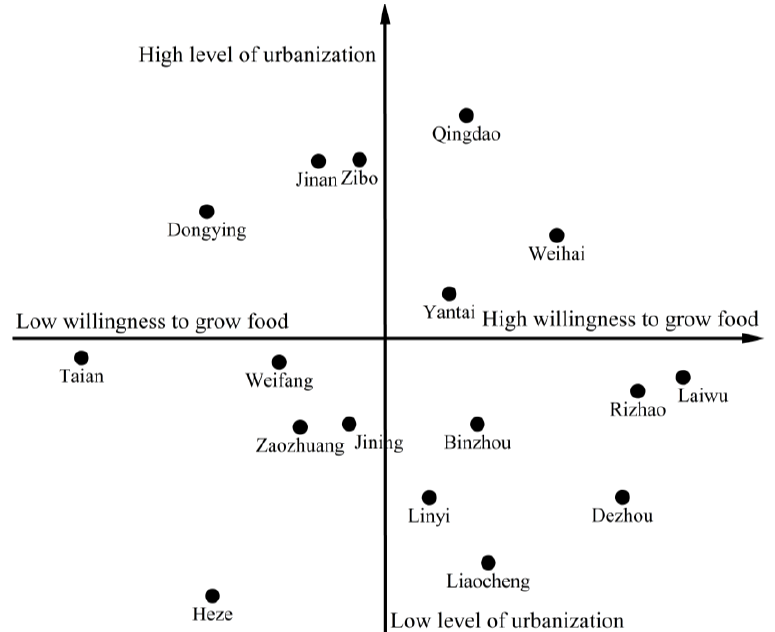
Figure 3. Differences in willingness to grow food in regions with different levels of urbanization.